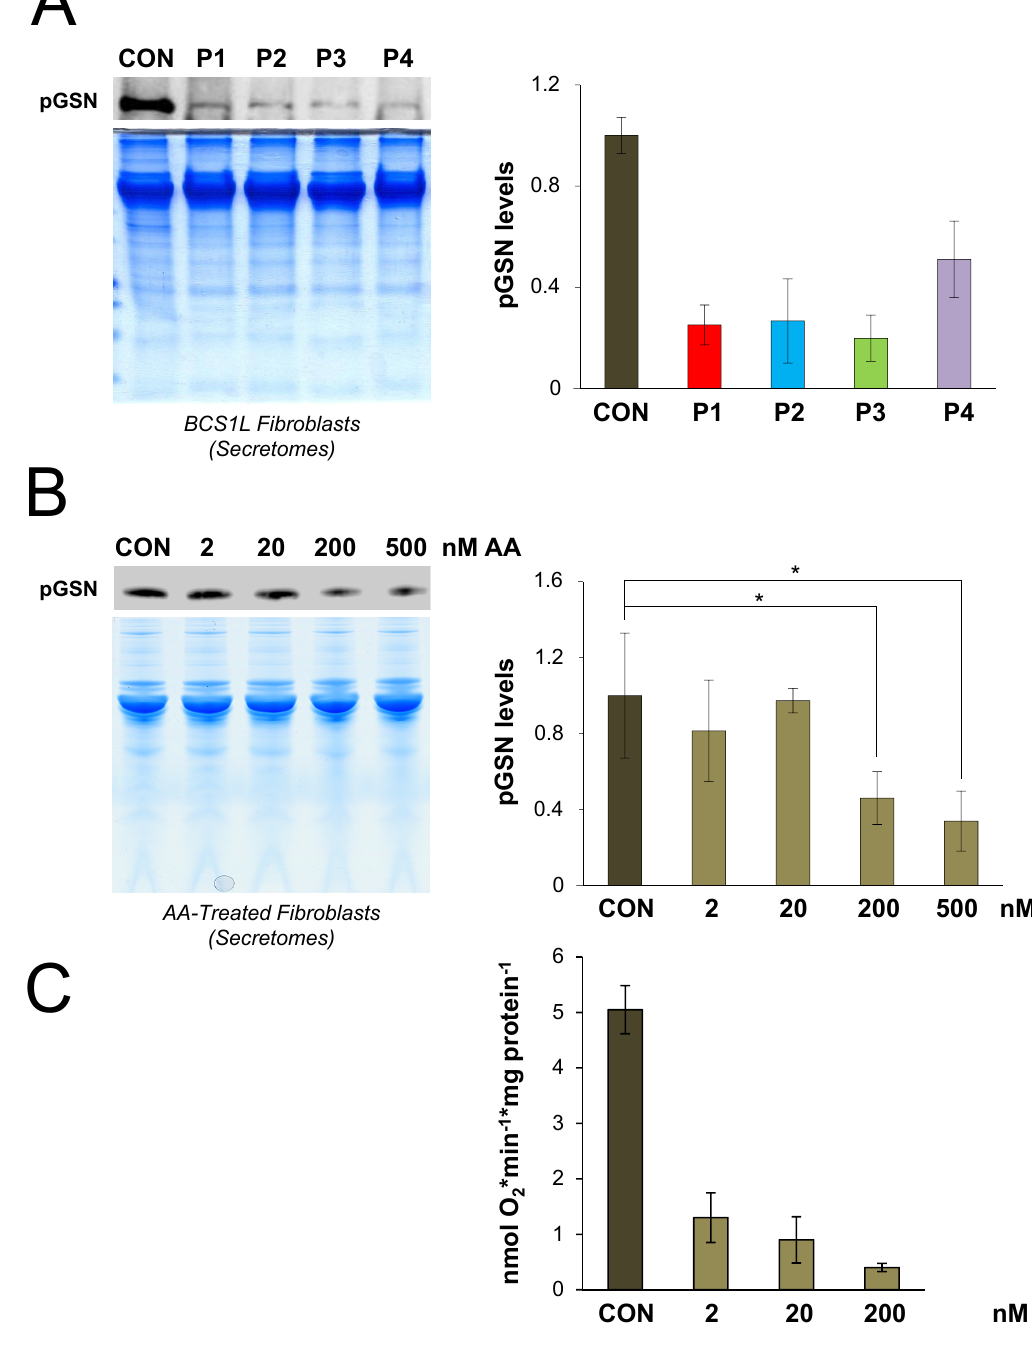
Figure 3. Plasma gelsolin levels are decreased in human fibroblasts with respiratory chain deficiency. ( A ) In total, 25 µ g of secreted protein extracts from control (CON) and mutant fibroblasts from patients (P1-P4) harboring pathogenic mutations in the assembly factor BCS1L were separated on 10%